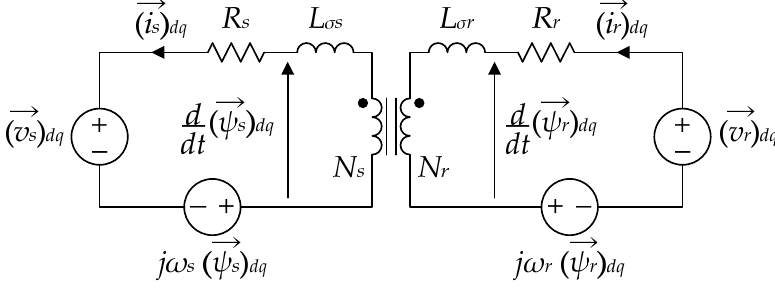
Figure 2. Equivalent circuit of the DFIG in the dq ‐ frame.